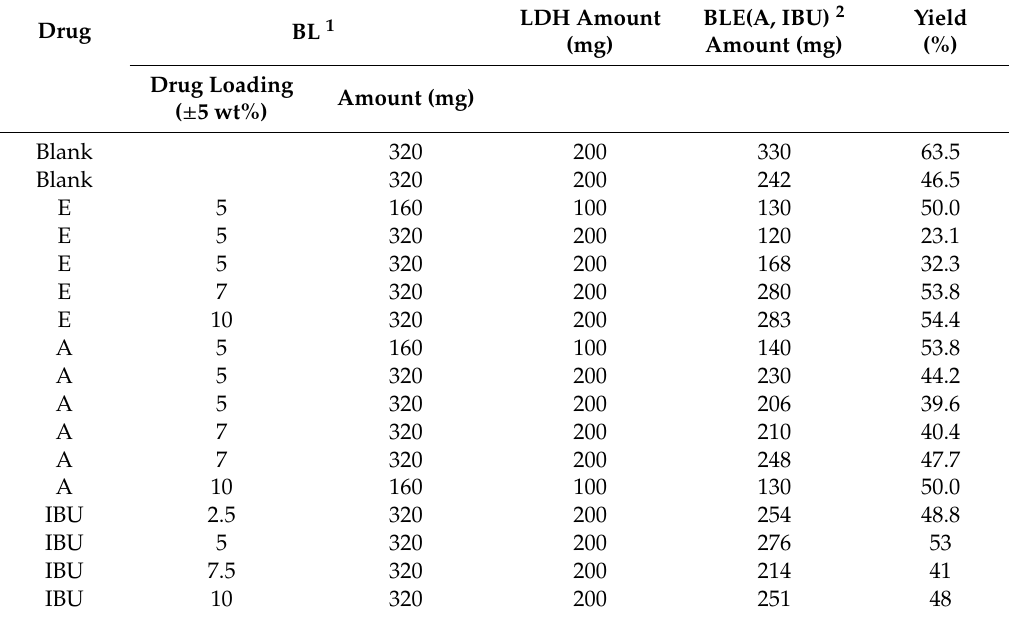
Table 2. Evaluation of the mass yield following the anionic